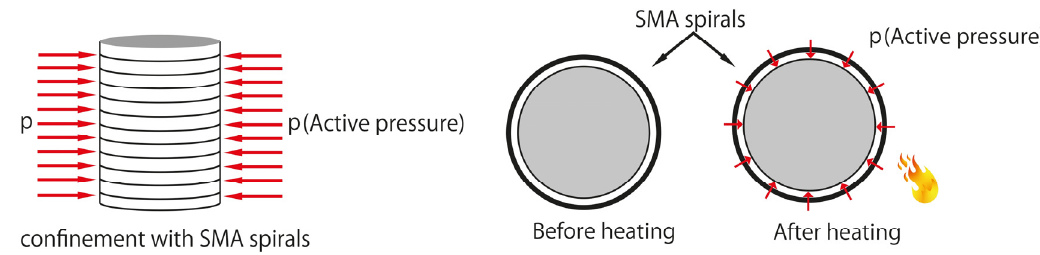
Figure 1. Schematic of a concrete column confined with SMA spirals (active confinement).